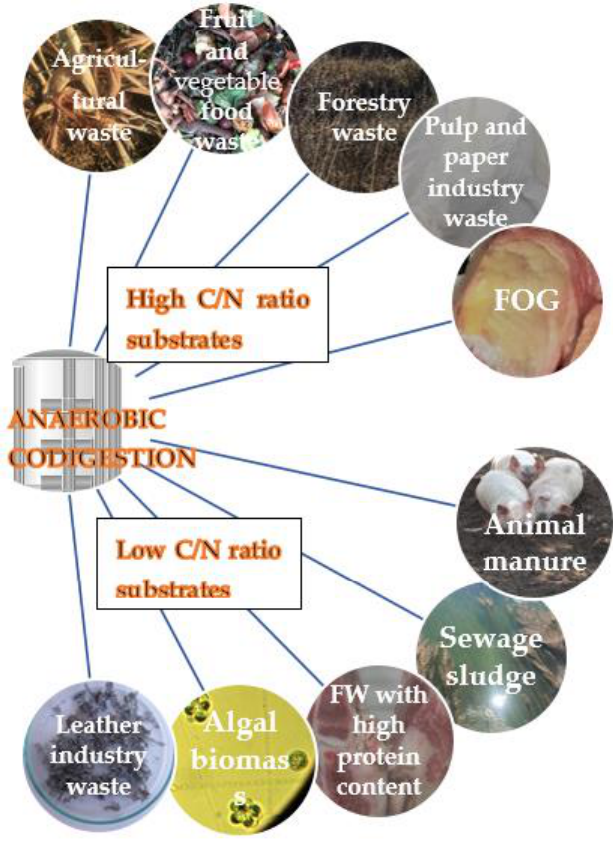
Figure 2. High and low C/N ratio substrates used in co-digestion.